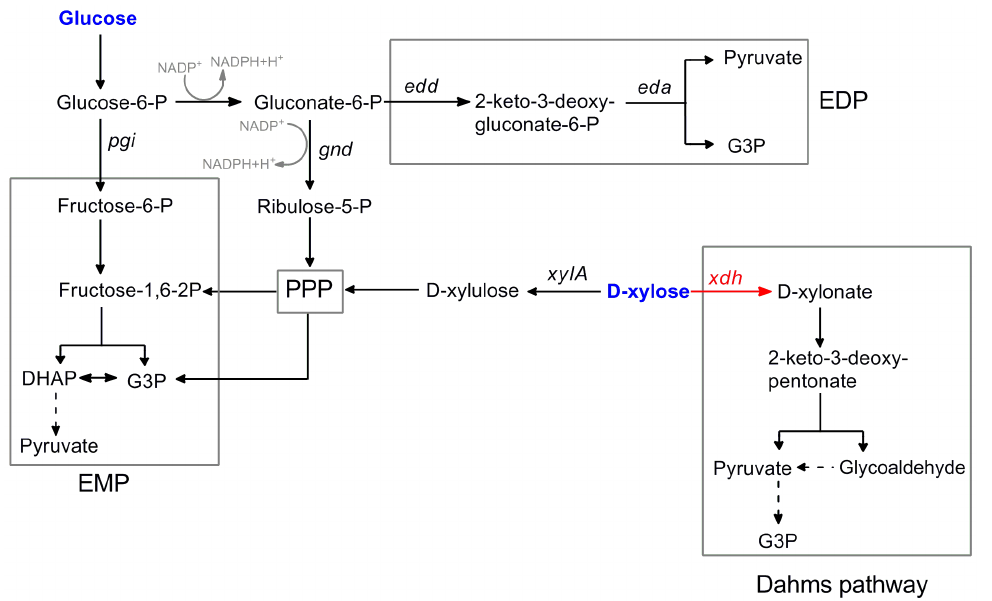
Figure 2. Four glycolytic pathways present in E.coli . EMP, Embden-Meyerhof pathway; PPP, pentose phosphate pathway; EDP, Entner- Doudoroff pathway.